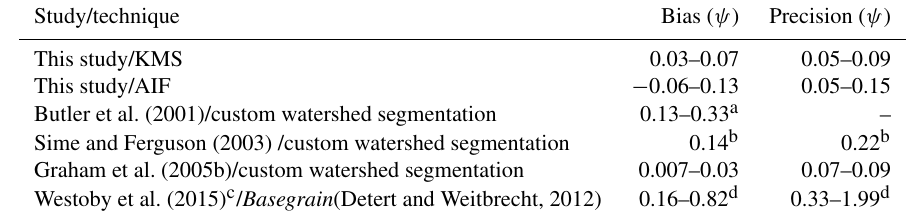
Table 1. Comparison of PebbleCounts and PebbleCountsAuto results with other segmentation-based pebble counting studies. Study/technique Bias ( ψ ) Precision ( ψ ) This study/KMS 0.03–0.07 This study/AIF 0.05–0.15 Butler et al. (2001)/custom watershed segmentation 0.13–0.33 a – Sime and Ferguson (2003) /custom watershed segmentation 0.14 b 0.22 b Graham et al. (2005b)/custom watershed segmentation 0.007–0.03 0.07–0.09 Westoby et al. (2015) c / Basegrain (Detert and Weitbrecht, 2012) 0.16–0.82 d 0.33–1.99